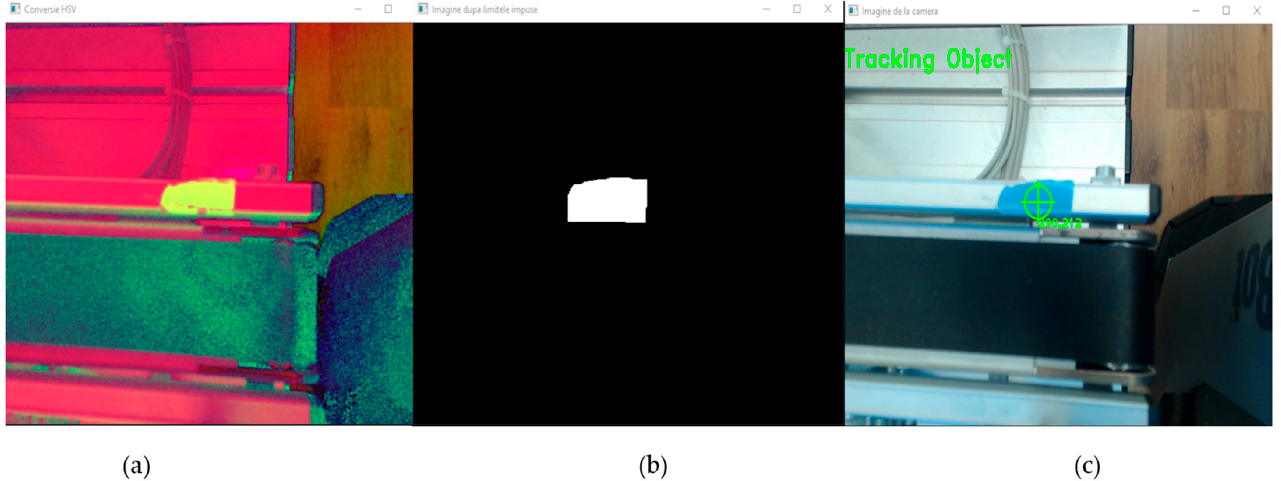
Figure 15. Object Detection of the reference point with the following steps: ( a ) Conversion from RGB to HSV ( b ) image segmentation after the color has been found between the HSV limits and the shape corresponding to reference has been found ( c ) reference object color and shape has been found and is being tracked.